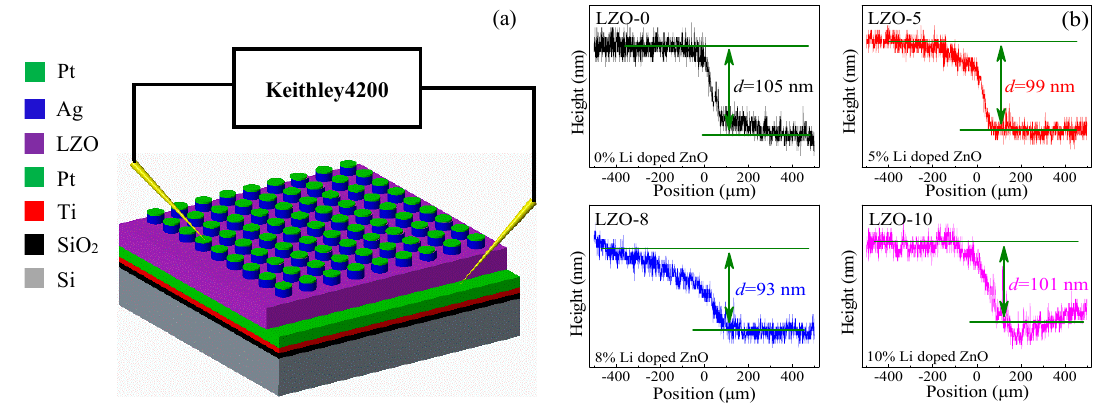
Figure 1. ( a ) The schematics of the Pt / Ag / LZO / Pt RRAM device. ( b ) The thicknesses of the ZnO thin films with different Li-doping contents.